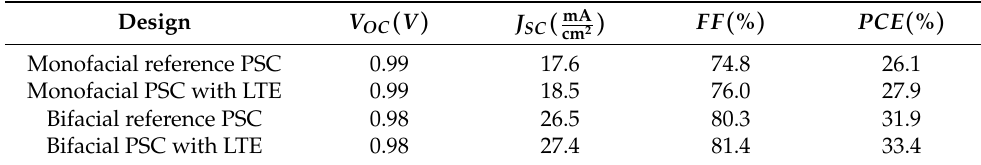
Table 3. Photovoltaic characteristics of monofacial and bifacial PSCs.